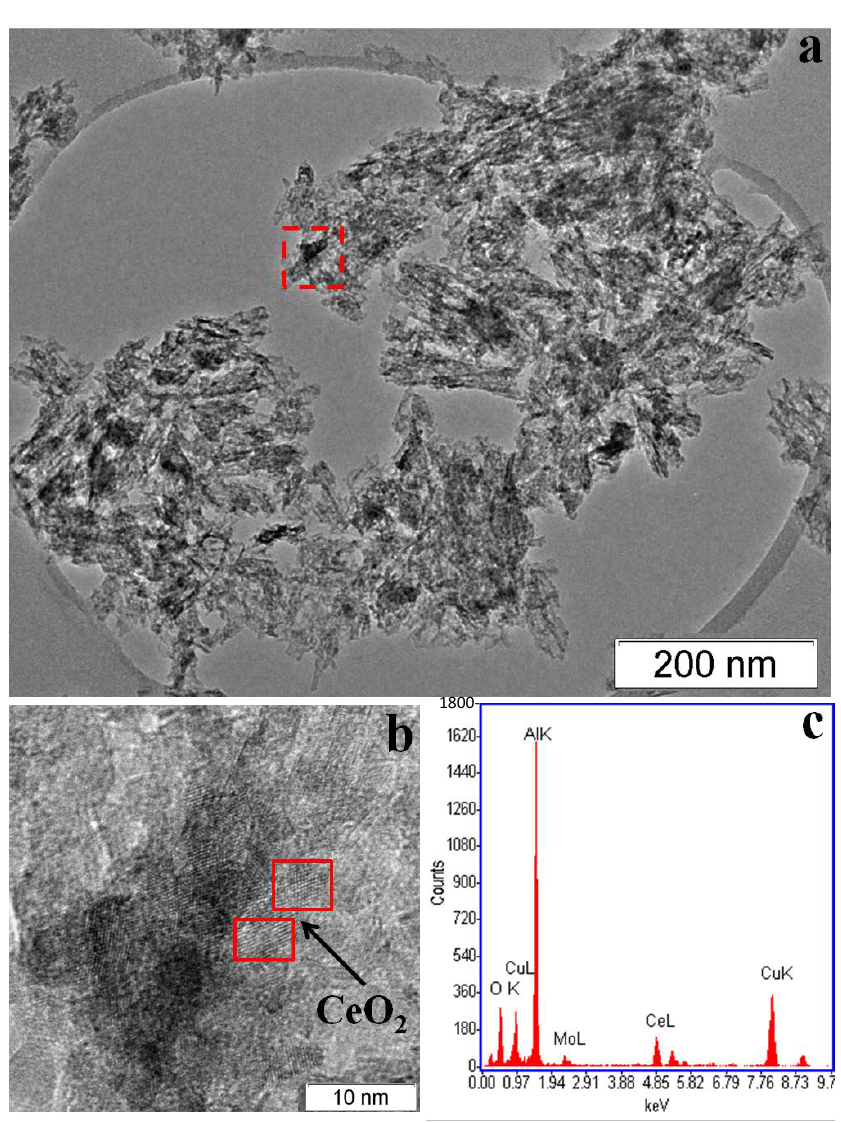
Figure 2. TEM image ( a ) of the fresh CuO-CeO 2 / γ -Al 2 O 3 catalyst and the HR TEM ( b ) and EDX spectra ( c ) of the marked